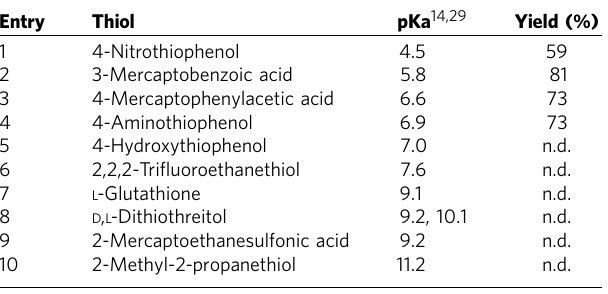
Table 1 | Aromatic and aliphatic thiol pKa values and corresponding yields in N–O bond cleavage